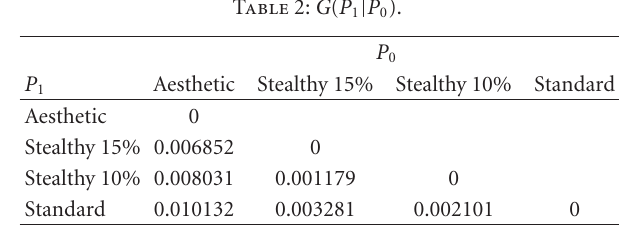
Figure 3: Stealthy pathfinding for trial 18 and γ = 15%.